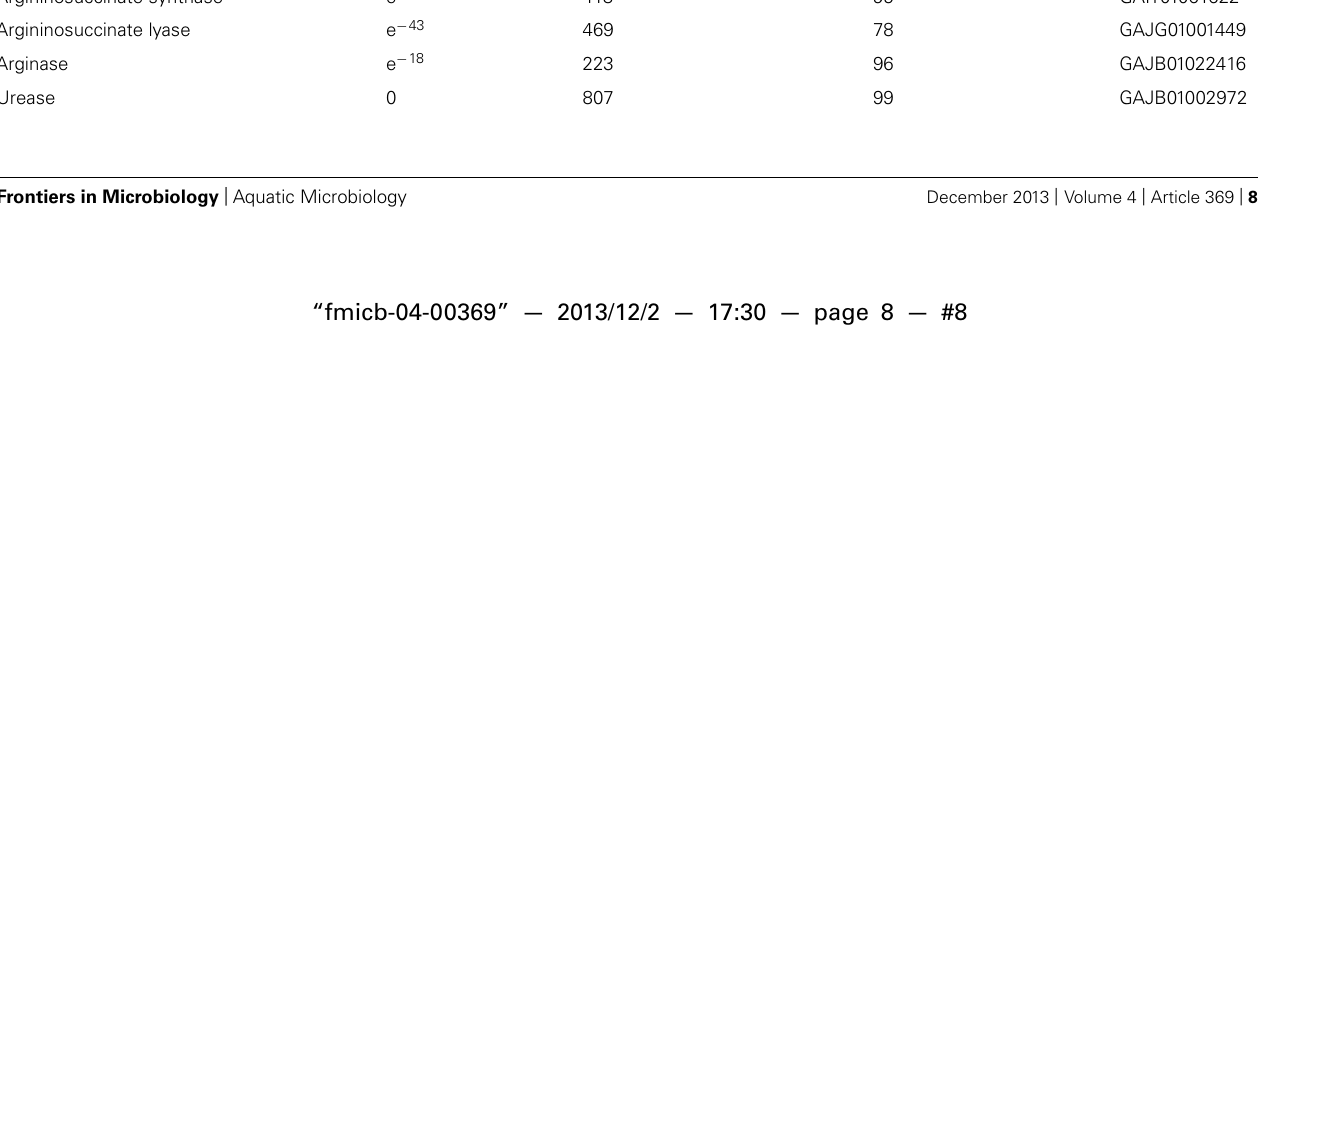
Table 2 | Nitrogen metabolizing enzymes similar to those in diatoms in the transcriptome of Alexandrium tamarense. Enzyme E -value Query length (AA) Carbamoyl phosphate synthase 0 Ornithine